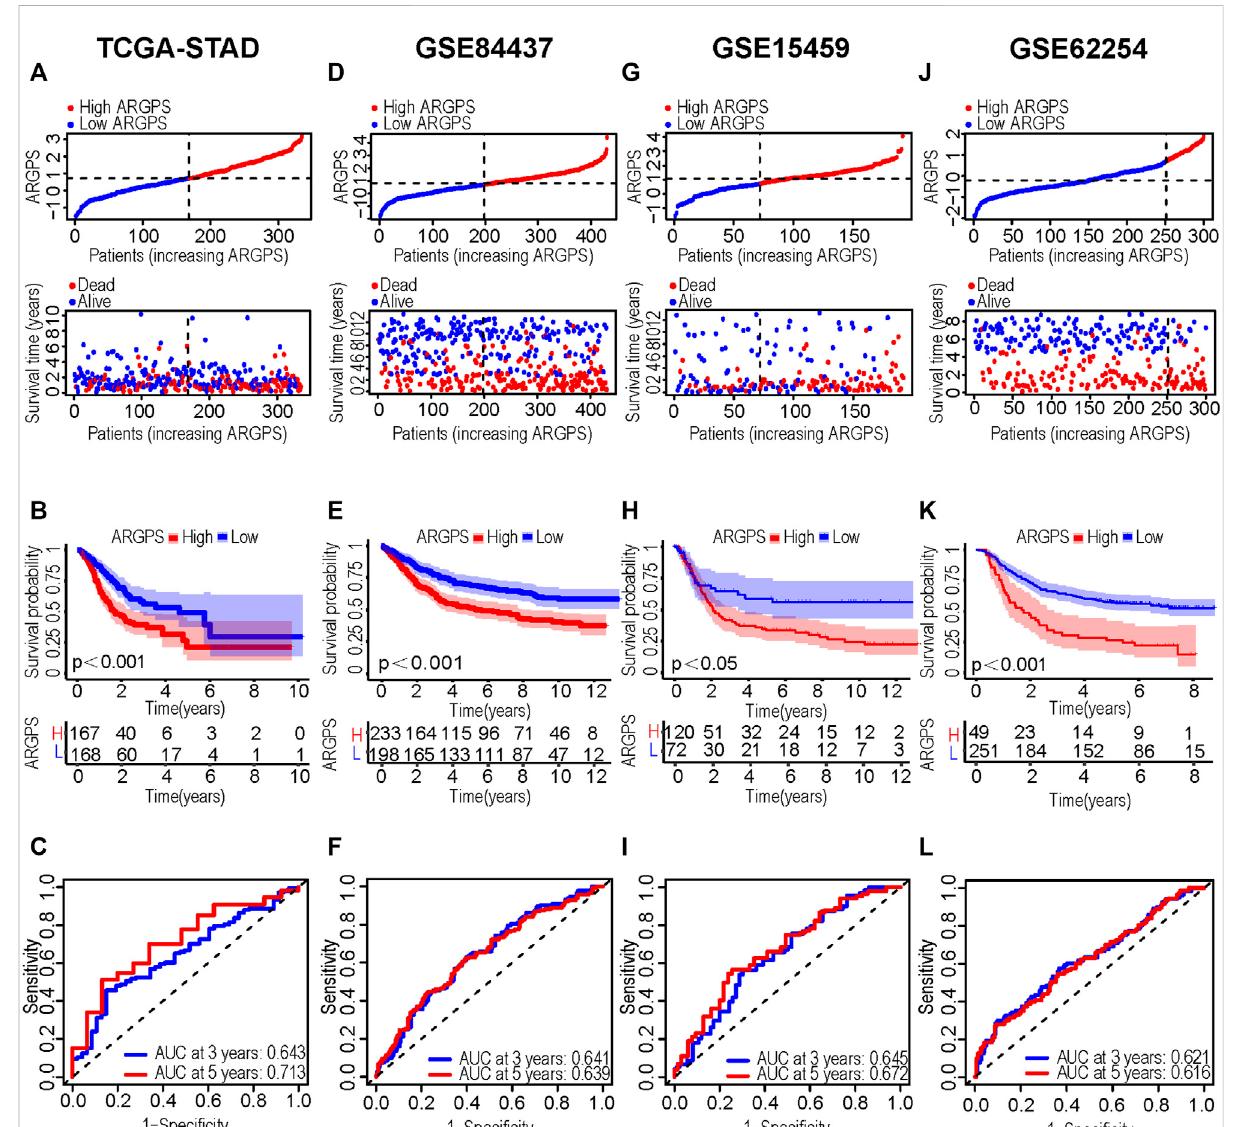
FIGURE 4 Construction and validation of the ARGPS model. (A,D, G,J) Distribution of ARGPS and relationship between ARGPS and survival status in the training and three testing sets. (B,E,H,K) The K-M survival curves of the high- and low-ARGPS groups in the training and three testing sets. (C,F,I,L) The time-dependent ROC curves for predicting OS at 3 and 5 years in the training and three testing sets. ARGPS, anoikis-related gene prognostic score; KM, Kaplan-Meier; ROC, receiver operating characteristic; OS, overall